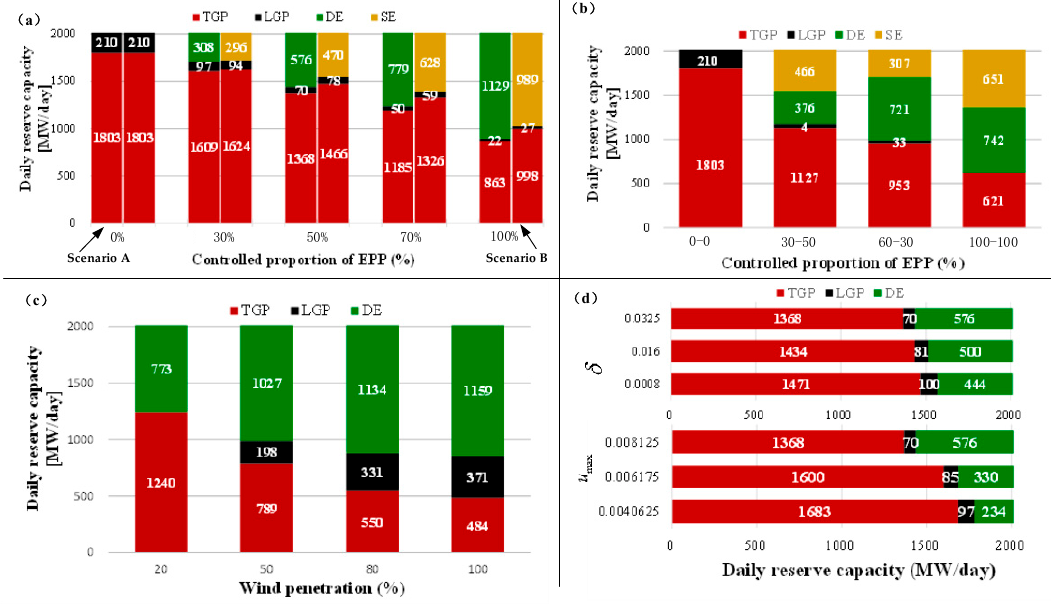
Figure 12. Reserves for TGP, LGP, and EPP in ( a ) Case-2, scenarios A and B; ( b ) Case-2, scenario C; ( c ) Case-3; and ( d ) Case-4